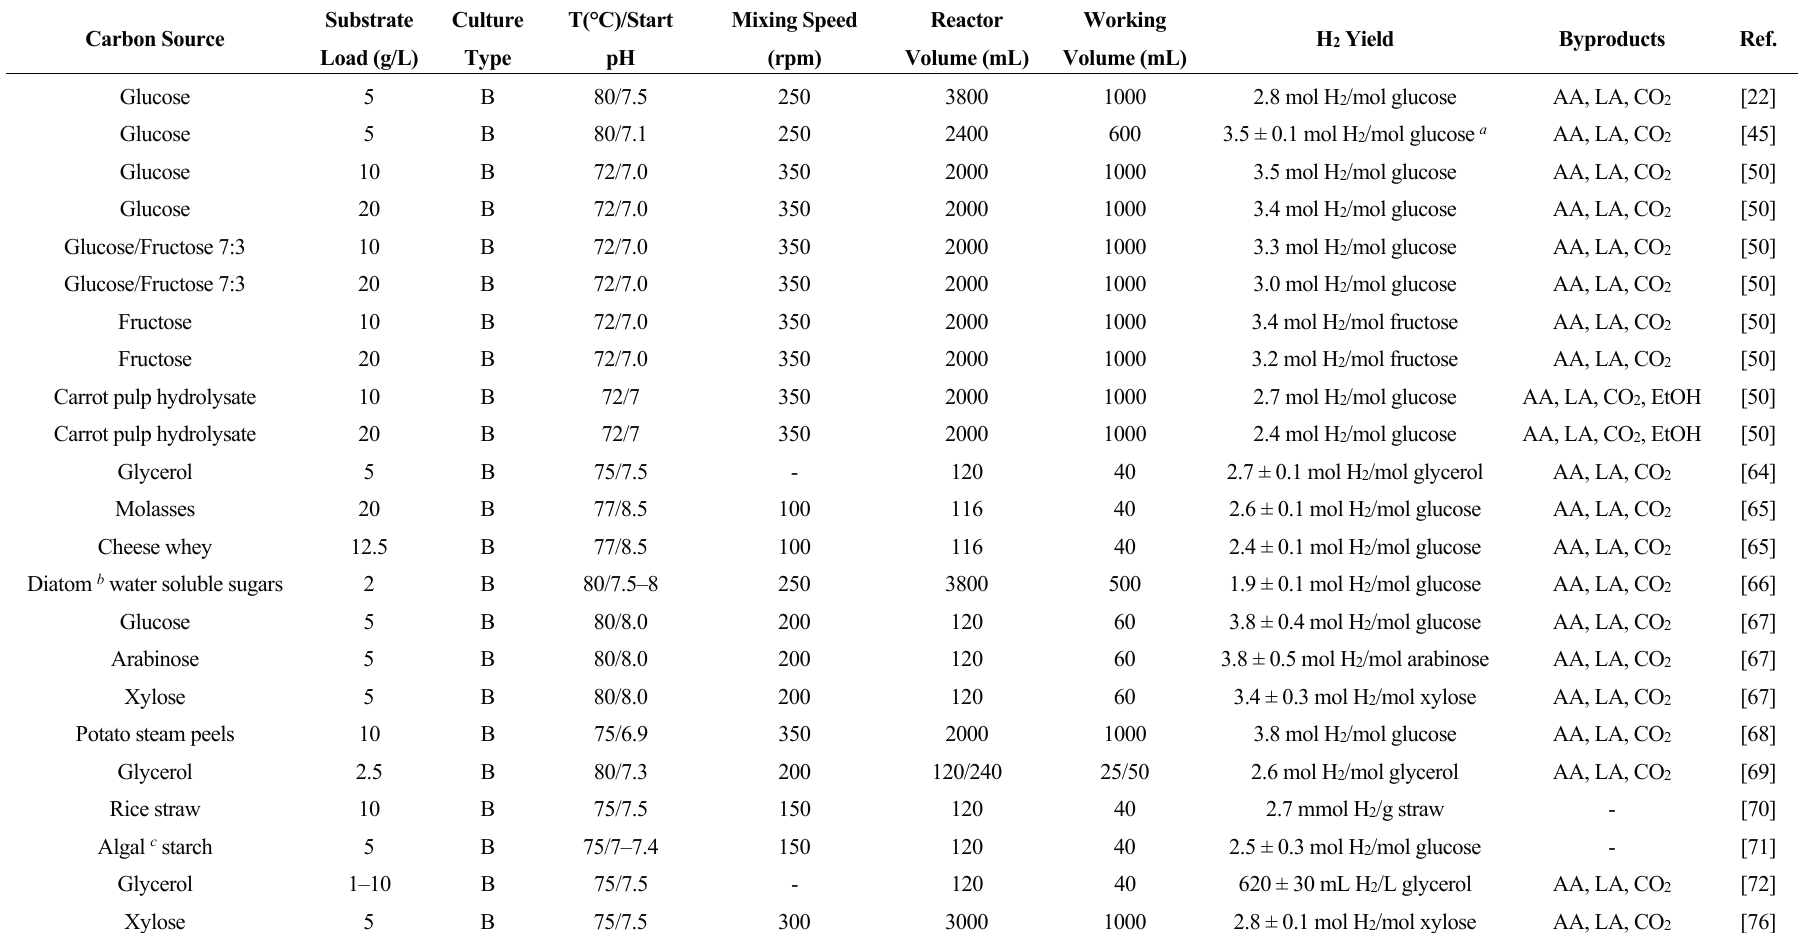
Table 1. H 2 production from various substrates by hyperthermophilic eubacterium T. neapolitana . B = batch; FB = fed-batch; AA = Acetic acid; LA = Lactic acid; EtOH =